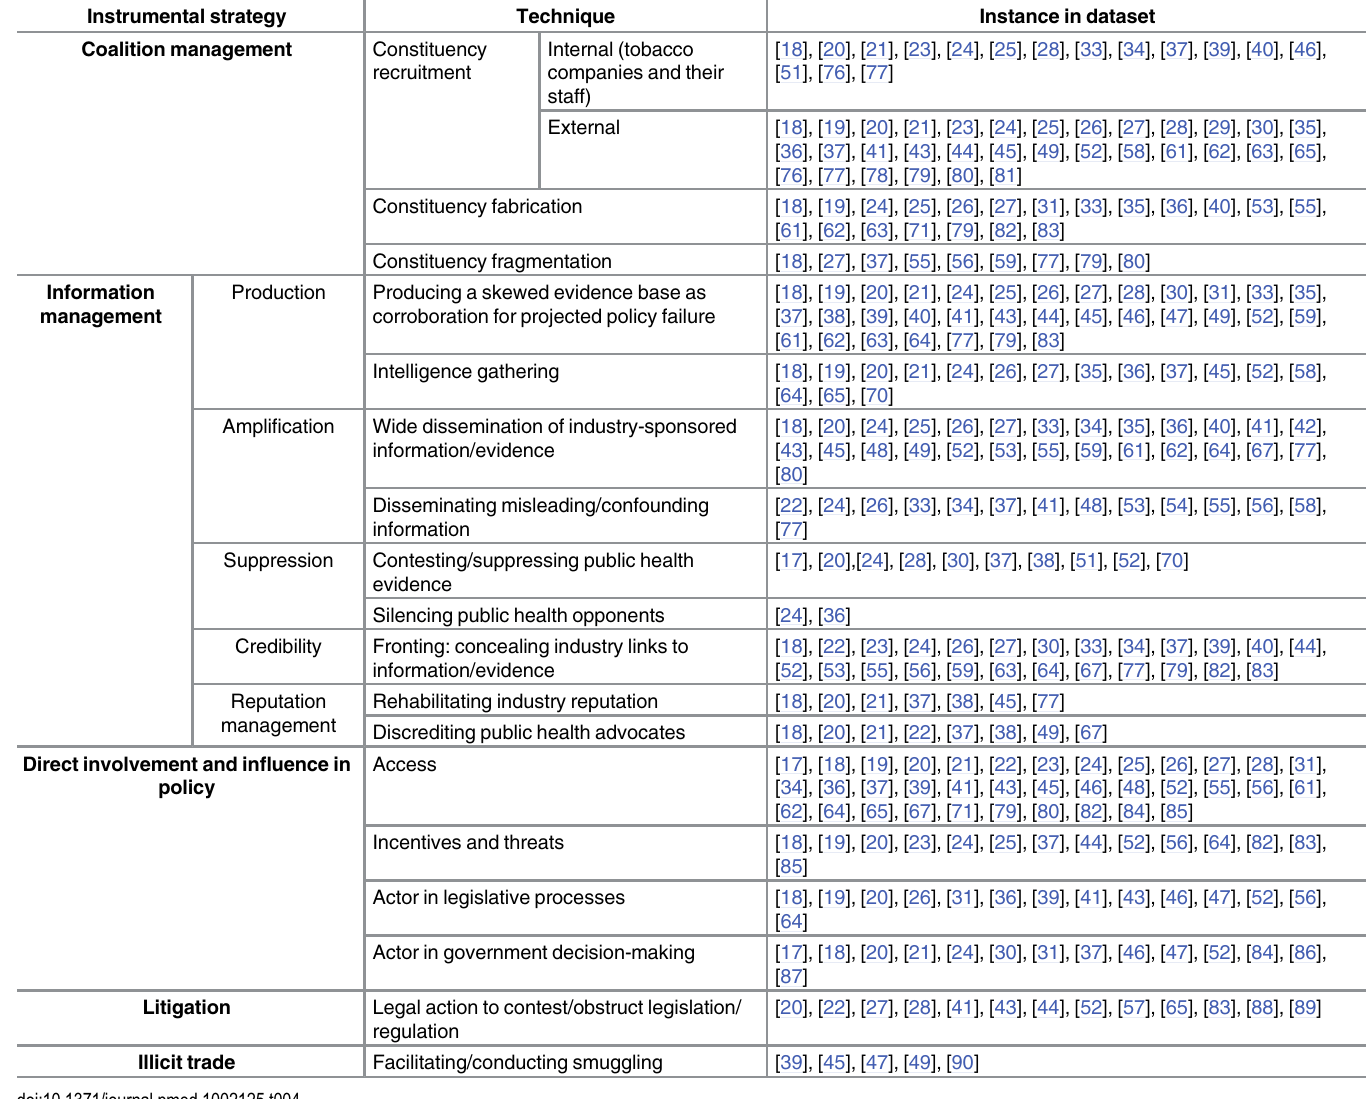
Table 4. Taxonomy of instrumental strategies and techniques used. Instrumental